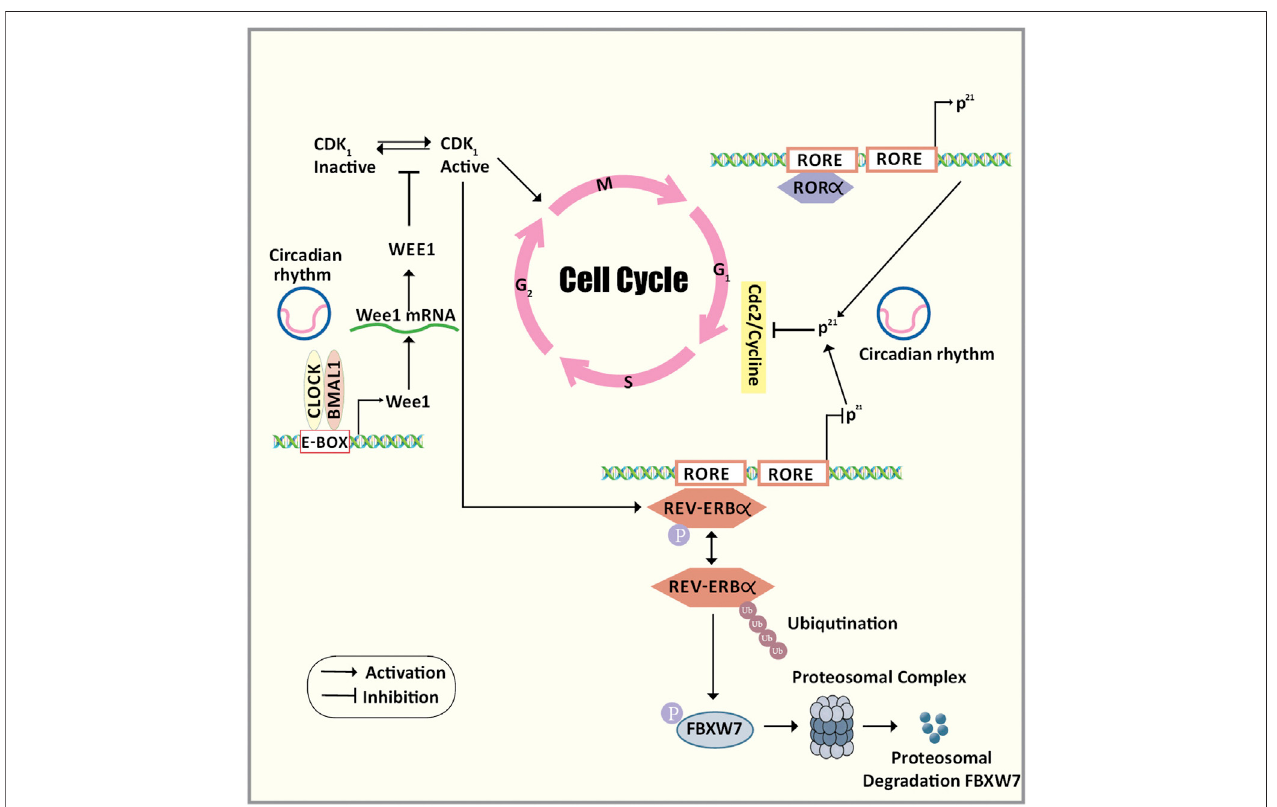
FIGURE 3 | The cross-talk between the cell cycle and the circadian rhythm. The cross-talk between the cell cycle and the circadian rhythm can occur via three major molecular mechanisms. Firstly, mitosis inhibitor protein kinase WEE1 regulates the G2/M transition by phosphorylating the amino acids of Cdk1 thereby inhibiting thekinaseactivityandpreventingentryintomitosis.Wee1genepromoterconsistsofCLOCK/BMAL1responsiveE-boxelementsthatcontroltheexpressionofWEE1in a circadian manner. Secondly, the transition of the G1 to S phase is under the circadian control ROR/REV-ERB pathway by targeting the p21Waf1/CIP1 a cyclin- dependent kinase inhibitor that negatively regulates the cell cycle progression. Thirdly, the phosphorylation of REV-ERB α via CDK1 targets this clock transcription inhibitorycomponentforubiquitination anddegradationbytheF-boxproteinFBXW7.Abbreviations:BMAL1,BoneMuscleArnt-likeprotein1;CDK1, Cyclin-dependent kinase 1; CLOCK, Circadian Locomotor Output Cycles Kaput; E-box, Enhancer box; F/box/FBXW7, F-Box And WD Repeat Domain Containing 7; G1 phase, Gap1 phase; G2/M transition, Gap2/Mitosis transition; p21Waf1/CIP1, Cyclin-dependent kinase inhibitor 1; REV-ERB α , nuclear receptor subfamily 1, group D, member 1; ROR, Retinoic acid receptor-related Orphan Receptor; S phase, Synthetic phase.